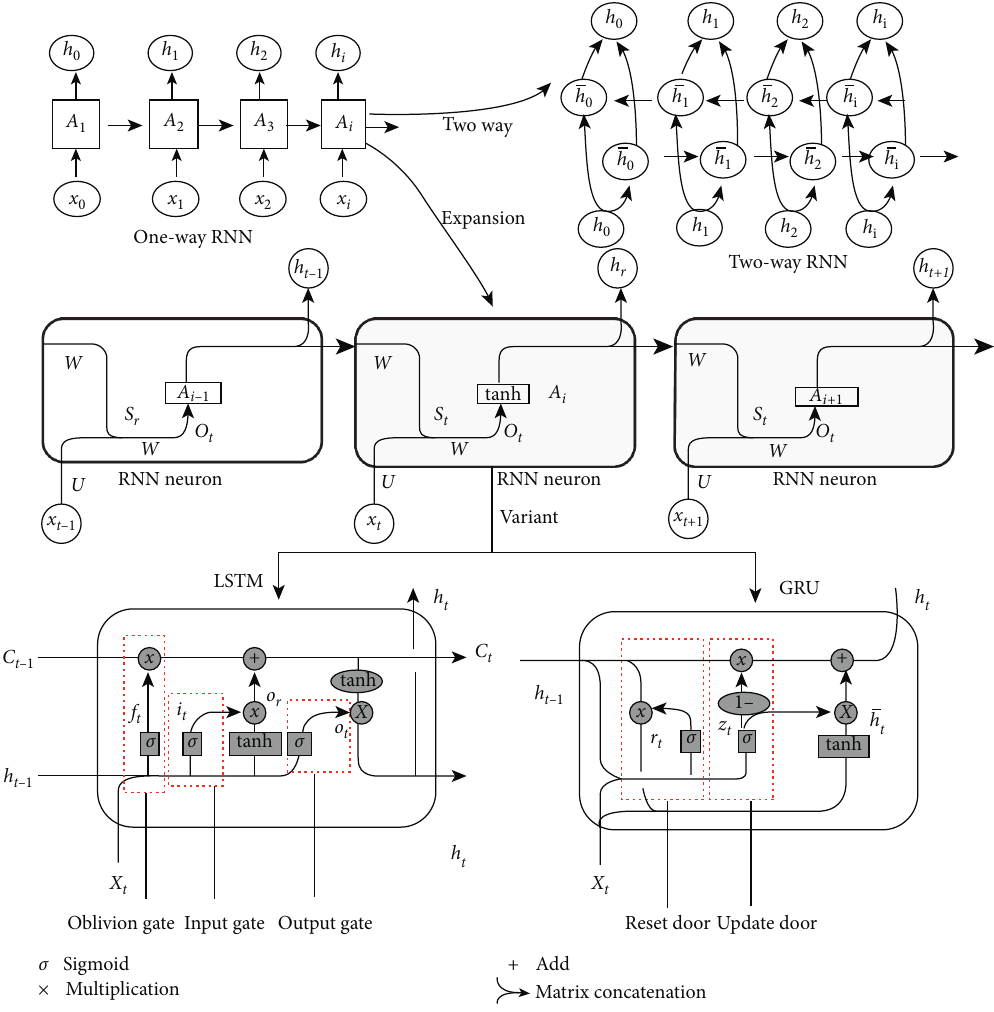
Figure 3: RNN and its variant neuron structural